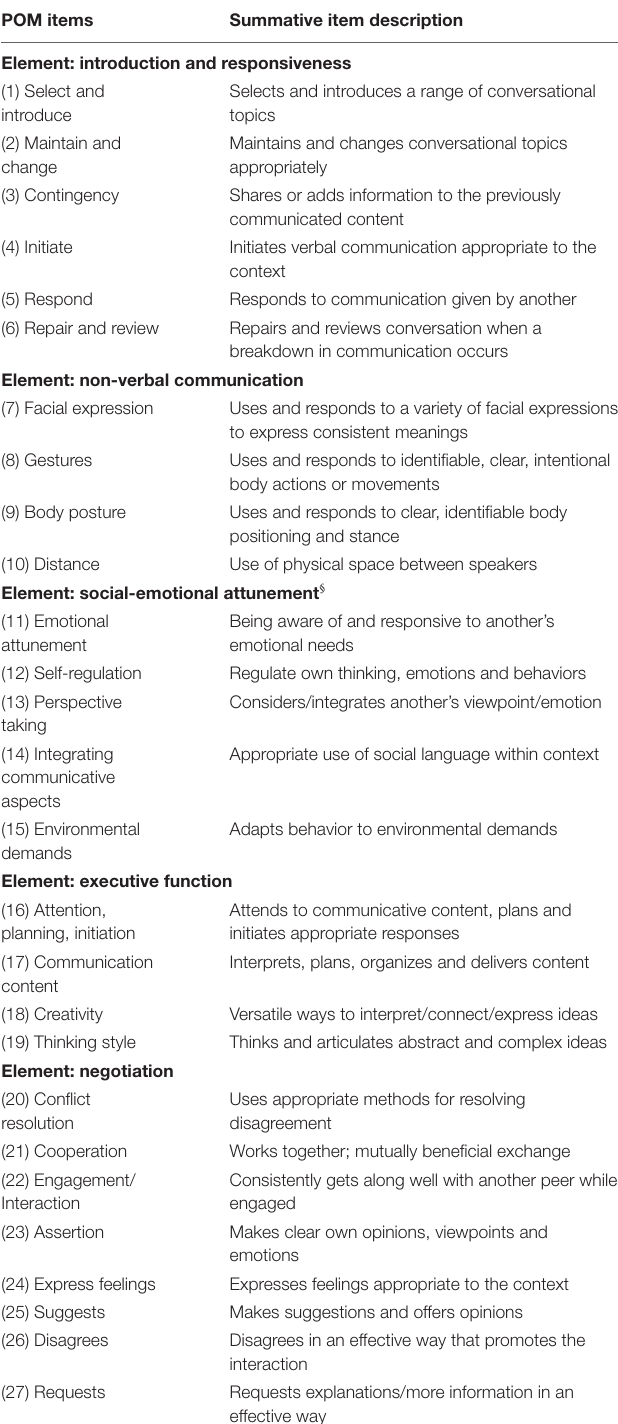
TABLE 1 | Pragmatics observational measure element and item